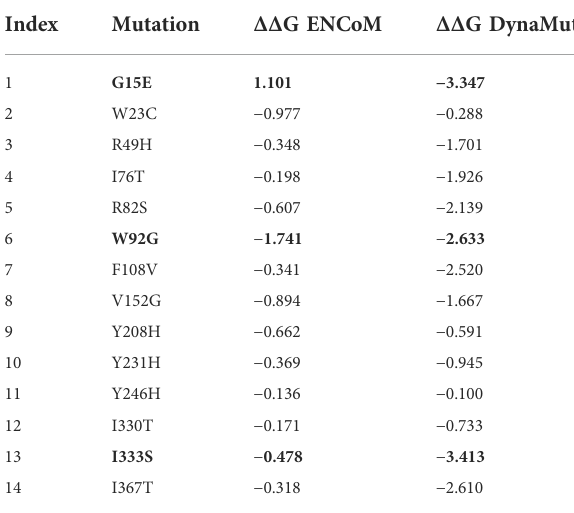
TABLE2ListofhighlydeleteriousanddestabilizingmutationsinIDH1. Among the 14 mutations, three are highly destabilizing reported by both the servers (mCSM and DynaMut) shown in